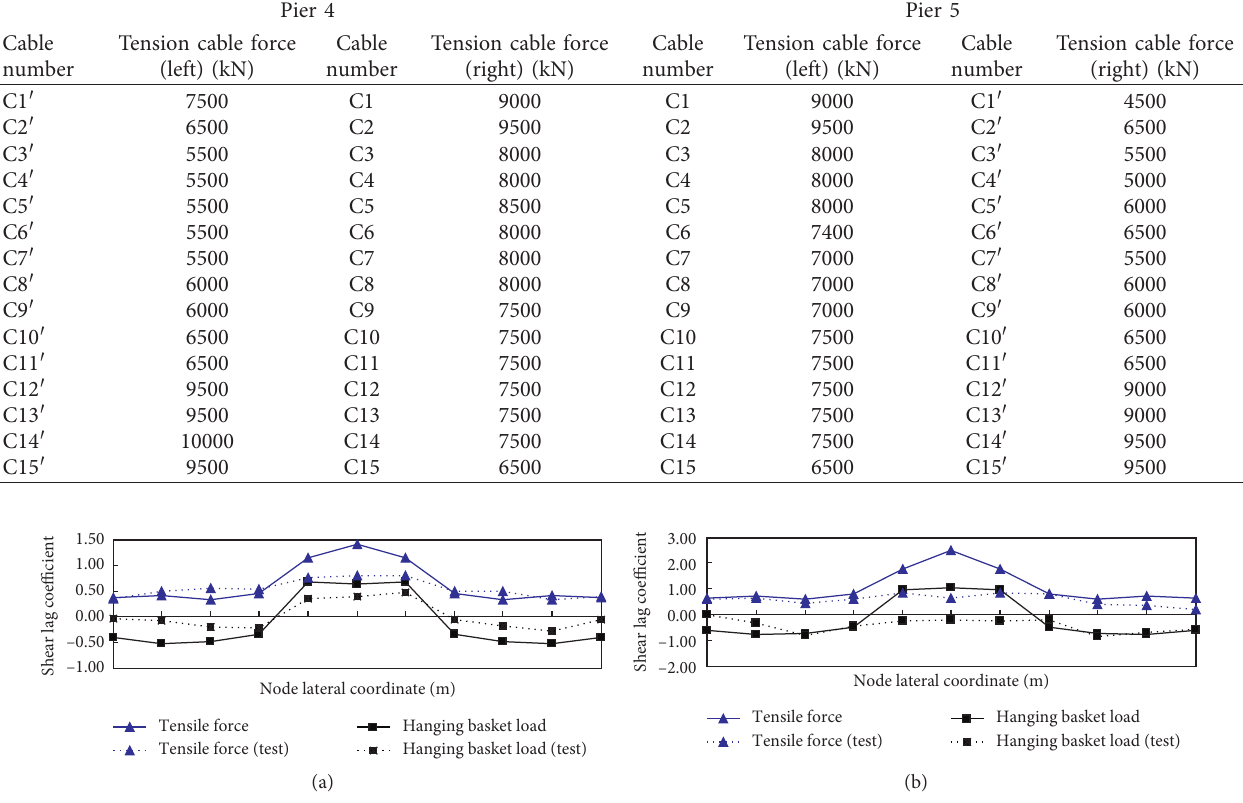
Figure 7: Shear lag coefficient variations in G1 and G2 (Condition 1): (a) G1 section; (b) G2